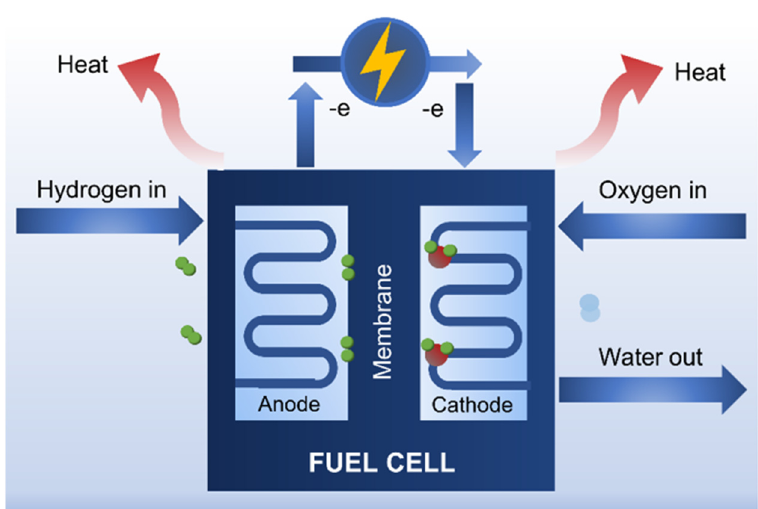
Figure 15. Mechanism of electricity generation in fuel cell.